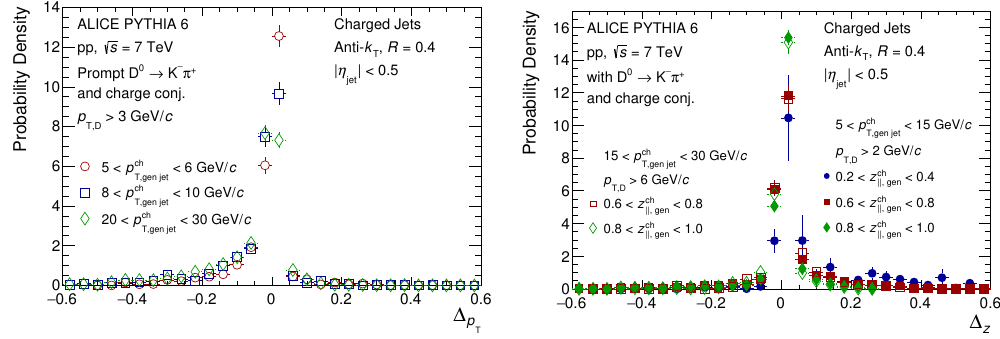
Figure 4 . Probability density distribution of (cid:1) p (left) and (cid:1) z (right) for D 0 -meson tagged jets p T in pp collisions at s = 7 TeV. Left: (cid:1) p is shown for 5 < p ch < 6 GeV =c (circles), 8 < T ; genjet T p ch < 10 GeV =c (squares) and 20 < p ch < 30 GeV =c (diamonds). Right: (cid:1) z is shown for T ; genjet T ; genjet 0 : 8 < z ch < 1 (diamonds), 0 : 6 < z ch < 0 : 8 (squares), 0 : 2 < z ch < 0 : 4 (circles); solid jj ; gen jj ; gen jj ; gen